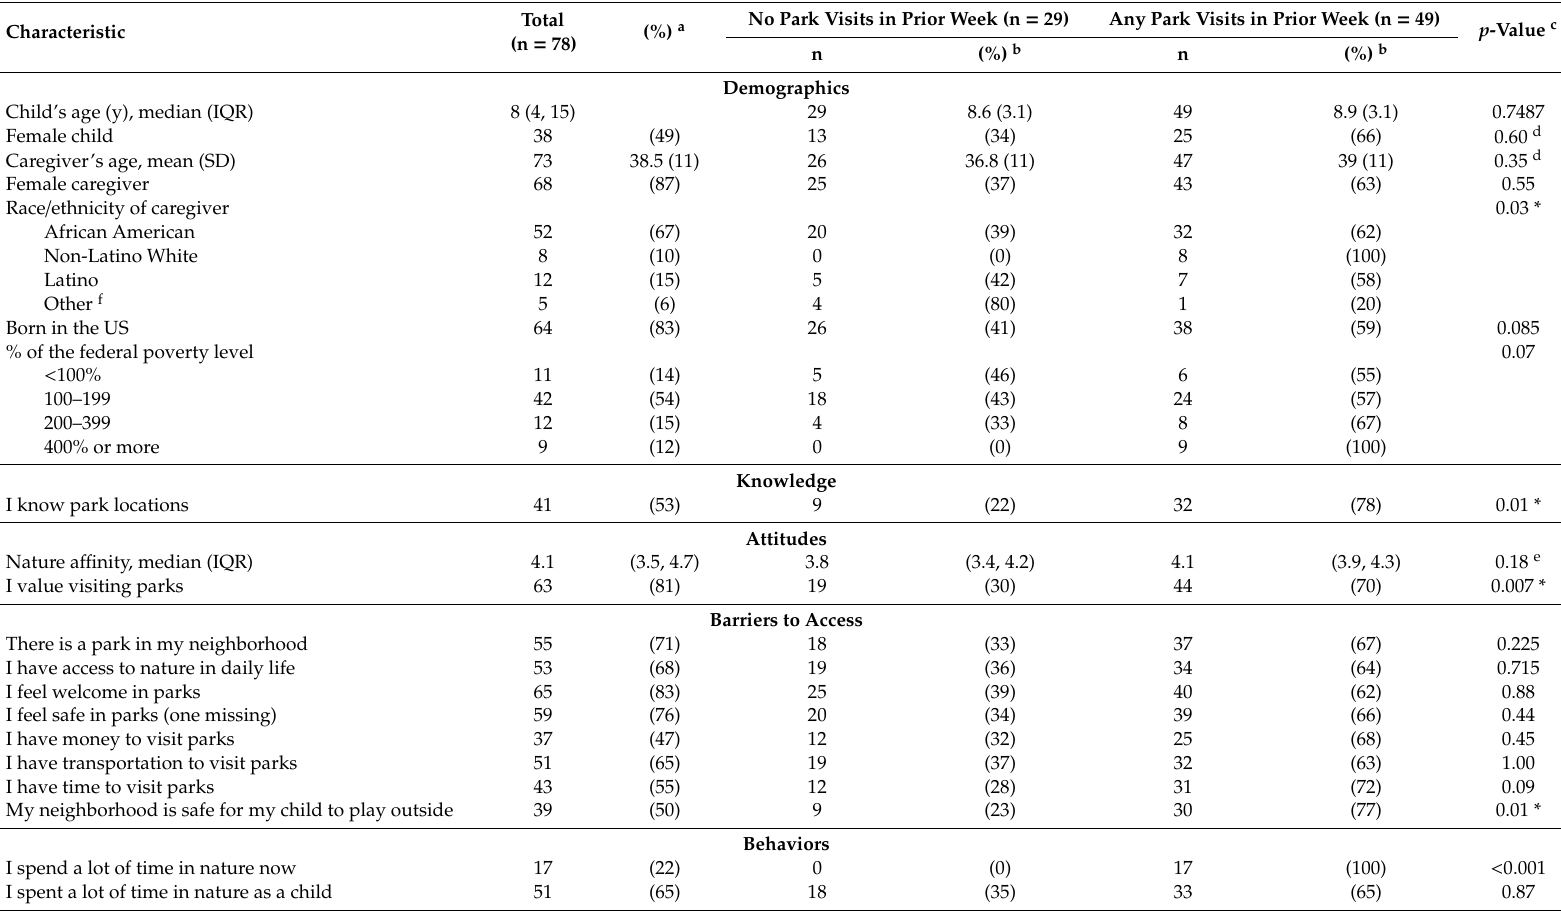
Table 1. Associations with zero or any weekly pre-baseline park visits and multivariable analysis of sociodemographics, attitudes, and access.